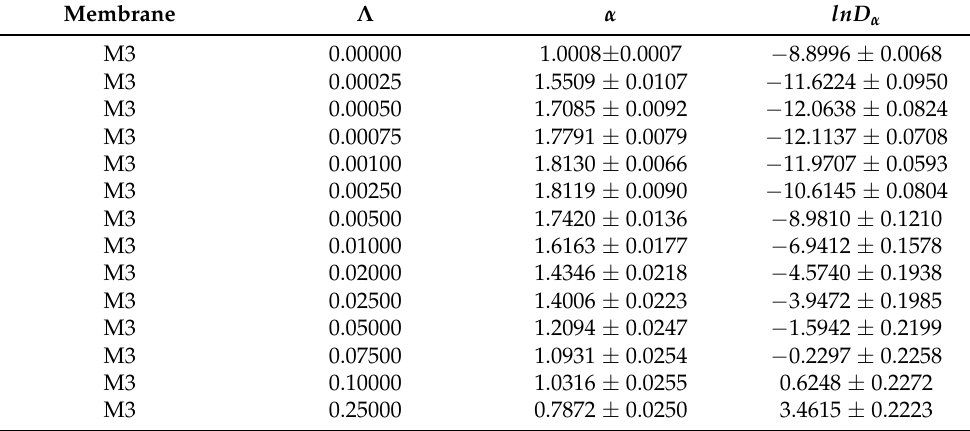
Table A4. Transport properties of artificial membranes with different structural parameters: